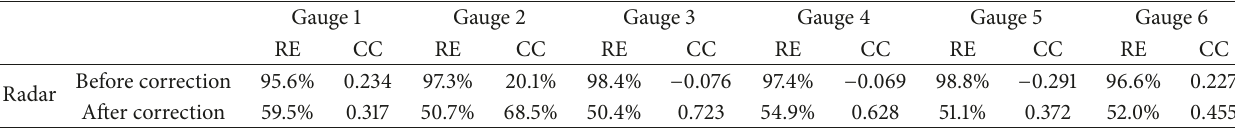
Table 4: Relative error (RE) and correlation coefficient (CC) between the rain rates estimated by gauges and the radar before and after attenuation correction.